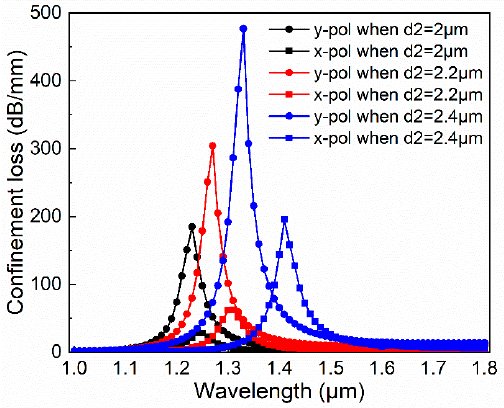
Figure 4. Dependence of transmission spectra in the x- and y-pol direction with different d 2 when d 1 is 1.2 μ m d 3 is 1.2 μ m, and t is 100 nm.